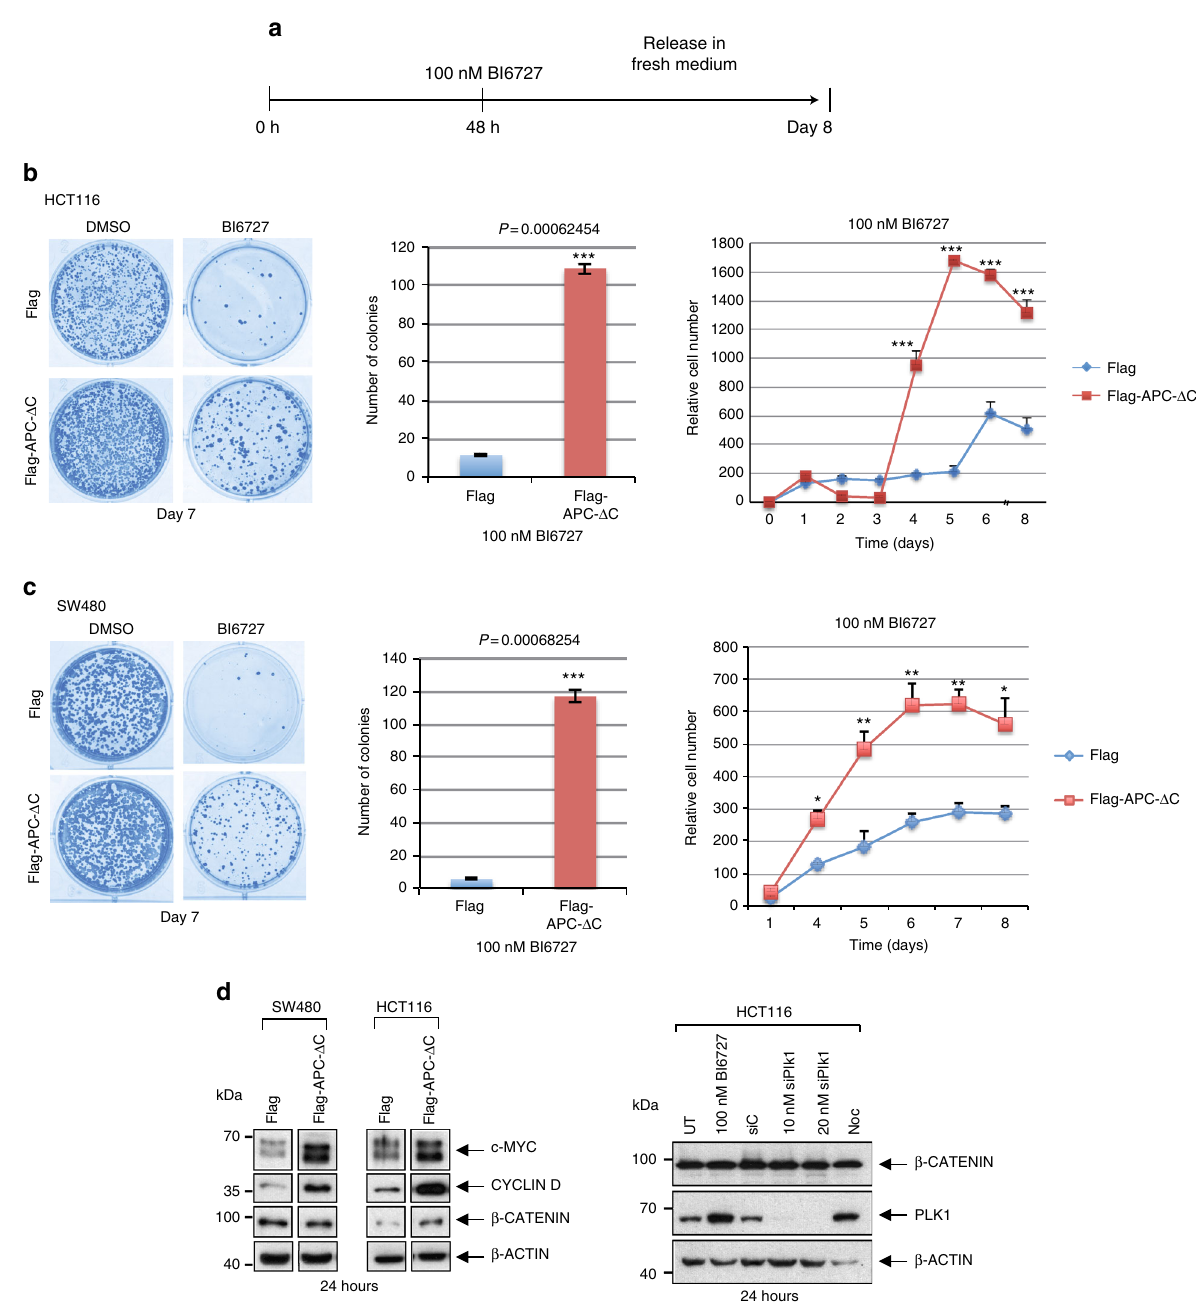
Fig. 4 Survival analysis of BI6727-treated, APC- Δ C-expressing colon cells. a Scheme of the experimental procedure. HCT116 and SW480 cells with or without APC- Δ C-expression were incubated in the presence of BI6727 (100 nM) for 48 h. On day 2, BI6727 was washed away, 1200 cells were replated in fresh medium and cultivated for 8 days. b HCT116 and ( c ) SW480 (Left) cells were subjected to Coomassie Blue staining and (Middle) the number of colonies was determined. (Right) The proliferative activity was assayed using an MTT assay, which is a method to quantify cell proliferation and viability. The assay is based on the conversion of water soluble MTT (3-(4,5-dimethylthiazol-2-yl)-2,5-diphenyltetrazolium bromide) compound to an insoluble formazan product. Viable cells with active metabolism convert MTT into formazan. Dead cells, on the other hand, lose this ability and therefore show no signal. Thus, color formation serves as a marker of only the viable cells. Over a period of 8 days the numer of viable cells was quanti fi ed. (means ± s.d., n = 3, for each time point). * P < 0.05, ** P < 0.01, *** P < 0.001, Student ’ s t -test, unpaired and two-tailed. d (Left) HCT116 and SW480 cells with or without APC- Δ C-expression were immunoblotted for c-MYC, Cyclin D, β -Catenin, and β -Actin. (Right) HCT116 cells were either untreated, treated with 100 nM BI6727, control siRNA siC, PLK1-speci fi c siRNA siPLK1 or Noc and then immunoblotted for β -Catenin, PLK1, and β mean number of chromosomes from 50.54 ± 3.73 to 61.09 ± 2.89 the 48 h-treatment with 100 nM BI6727 (Fig. 5b, c). In APC- Δ C- at day 12 following treatment, in APC- Δ C-expressing cells a rise expressing cells kept under the same conditions an increase from from 61.23 ± 5.55 to 84.95 ± 7.24 was determined (Supplementary 47.1 ± 3.06 to 87.84 ± 9.9 was determined. While the same treat- Fig. 5b, c) suggesting that both treatments (1) expression of APC- ment (48 h, 100 nM BI6727) of CIN + SW480 cells increased the